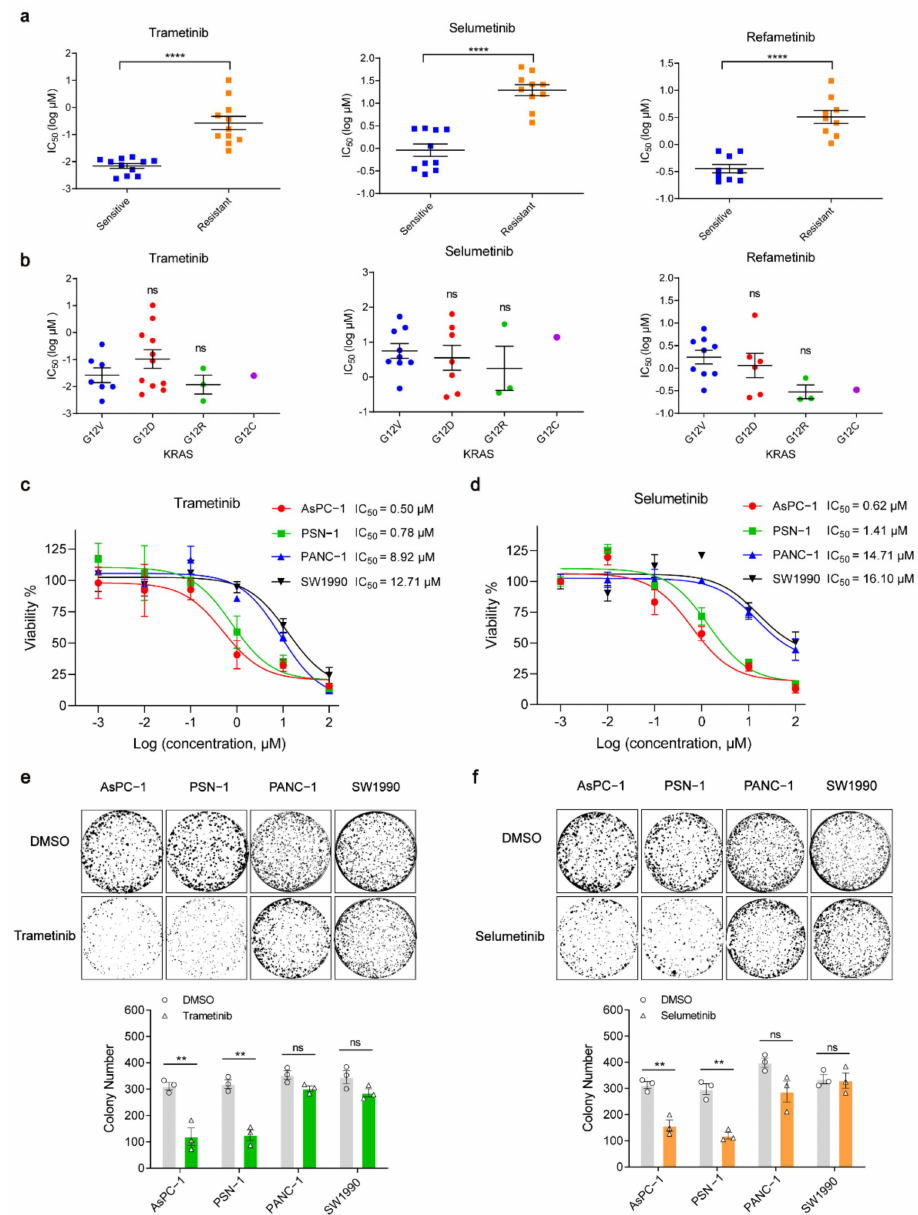
Figure 1. KRAS -driven pancreatic cancer cells have different sensitivities to MEK inhibition. ( a ) Com- parison of the sensitivity of KRAS -mutant pancreatic cancer cell lines treated by different kinds of MEK inhibitors. **** p < 0.0001. Information of logIC 50 was from the Genomics of Drug Sensitivity in Cancer (GDSC) database. ( b ) IC 50 values of four subtypes of mutant amino acid at KRAS codon 12. Average IC 50 values of cell lines with specific KRAS mutational subtypes were compared with average IC 50 values of cell lines with KRAS (G12V) to determine the p -value, Mann–Whitney test, ns, not significant. ( c , d ) Cell viabilities of SW1990, PANC-1, AsPC-1, and PSN-1 cell lines treated for 72 h with trametinib or selumetinib. ( e , f ) Colony formation of the cell lines in ( c , d ) were assessed for 12 days with DMSO, trametinib (100 nM) or selumetinib (200 nM), respectively. ** p < 0.01; ns,